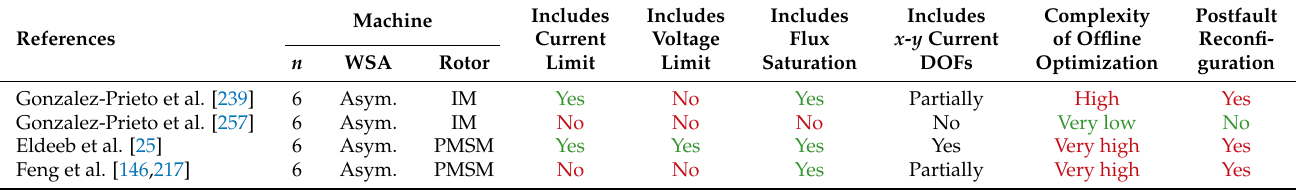
Table 13. Offline methods for optimization of the i d neglecting space harmonics (Section 3.5.1.4) in multiphase applications in the literature. Includes Includes